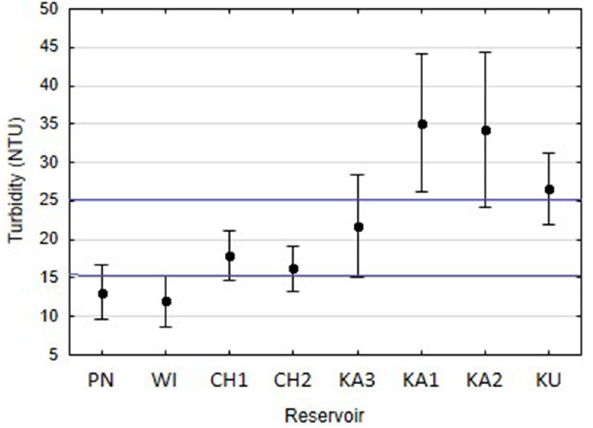
Figure 5. Water turbidity levels (mean ± SD) in 2014–2016, based on which the analysed reservoirs were divided into turbidity classes (HT, MT and